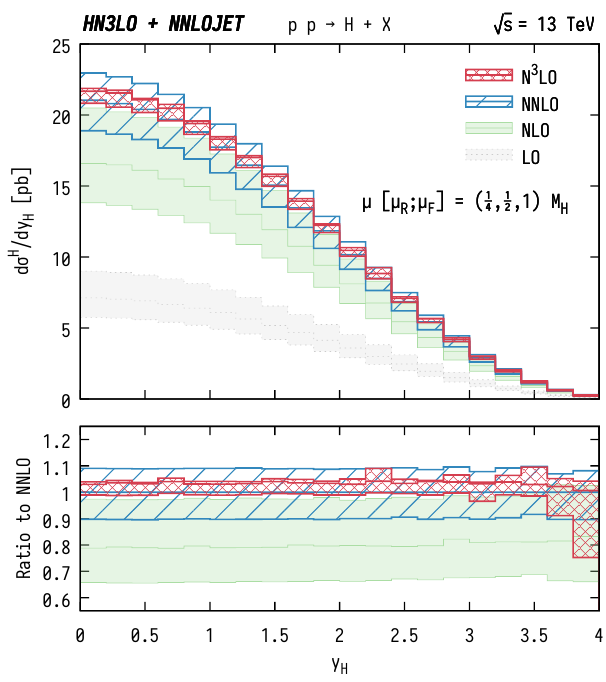
Figure 6 . Rapidity distribution of the Higgs boson computed using the q T subtraction formalism up to N 3 LO. The seven-point scale variation bands (as stated in table 1) of the LO, NLO, NNLO and N 3 LO ( C N 3 ) results are as follows: LO (pale grey (cid:12)ll), NLO (green (cid:12)ll), NNLO (blue hatched) and N 3 LO ( C N 3 ) (red cross-hatched). The central scale ( (cid:22) = M H = 2) at each perturbative order (except LO) is shown with solid lines. In the lower panel, the ratio to the NNLO prediction is shown. While the bands for the predictions at LO, NLO and NNLO are computed with the seven scales as detailed in the text, the N 3 LO ( C N 3 ) band is obtained after considering also the uncertainties due to the variation of the q cut